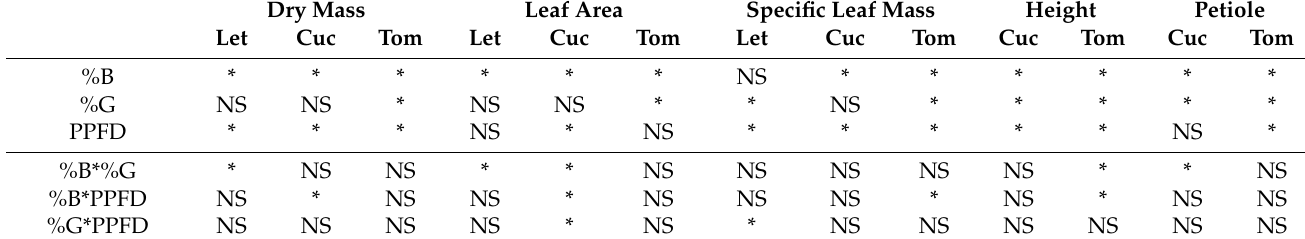
Table 2. Significant effects of percent blue (%B), percent green (%G) and PPFD, along with interaction terms on the parameters of dry mass, leaf area index, specific leaf mass, height and longest petiole. * represents a significant effect at p < 0.05. NS, not significant. Let: lettuce; Cuc: cucumber; Tom: tomato.